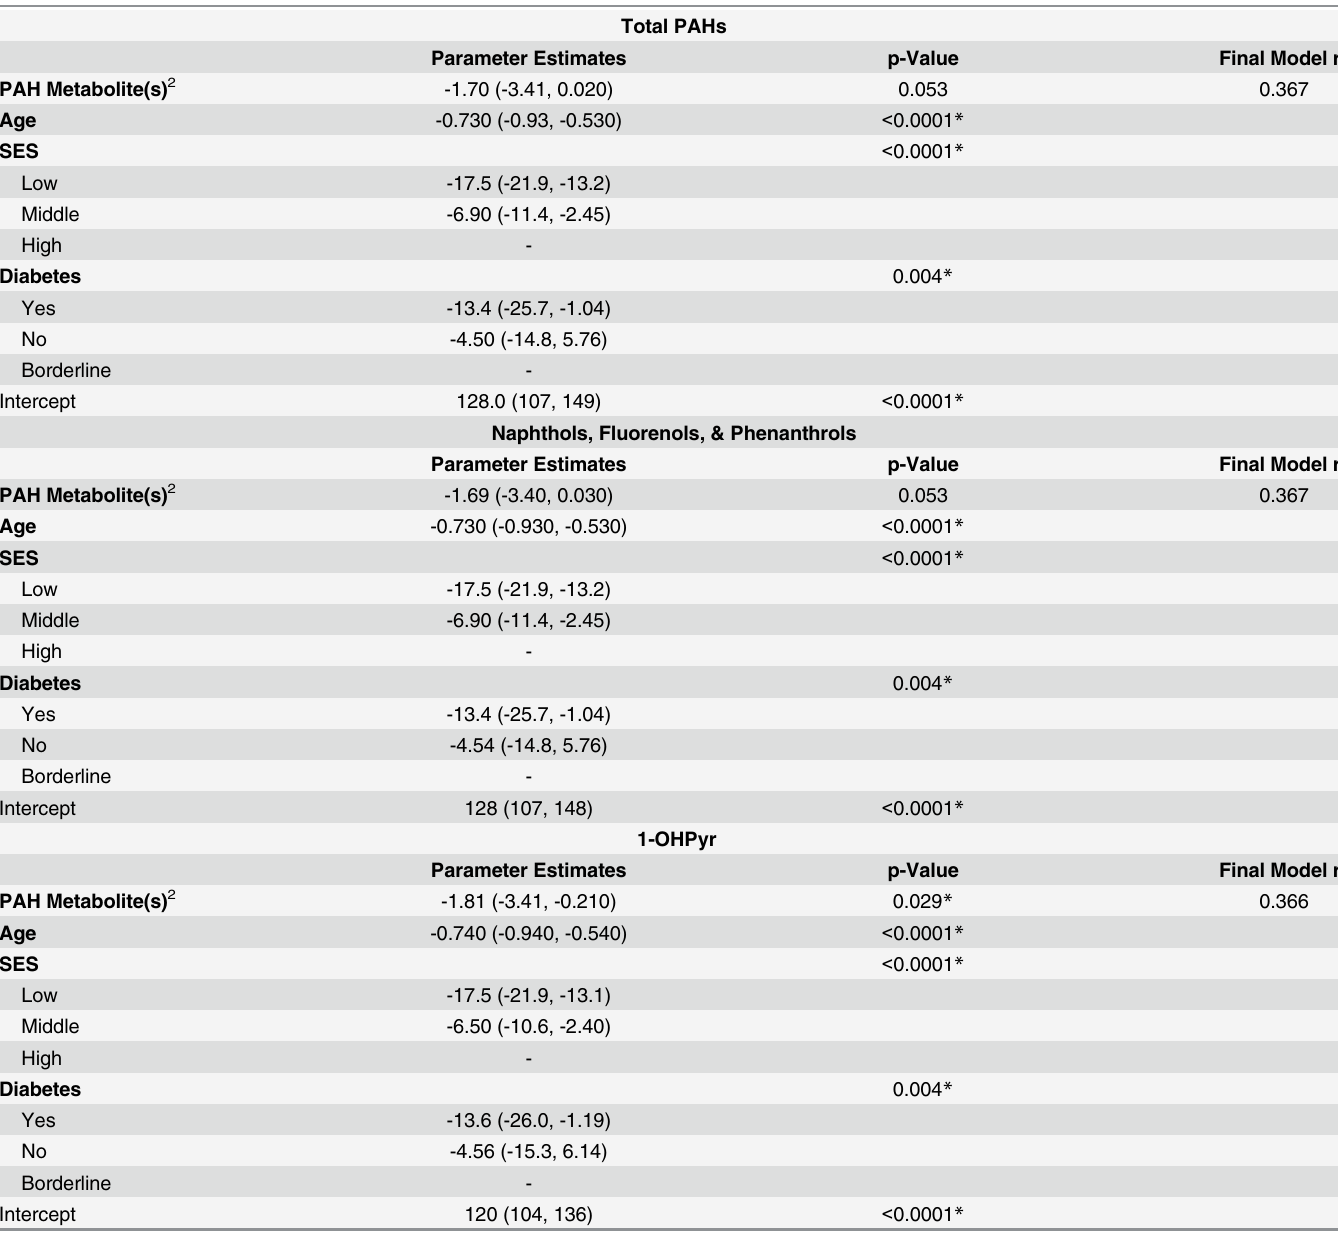
Table 5. Parameter Estimates (95% CIs) and Coefficient of Determination of Digit Symbol Substitution Test Scores by Final Model Covariates 1 for each PAH Metabolite